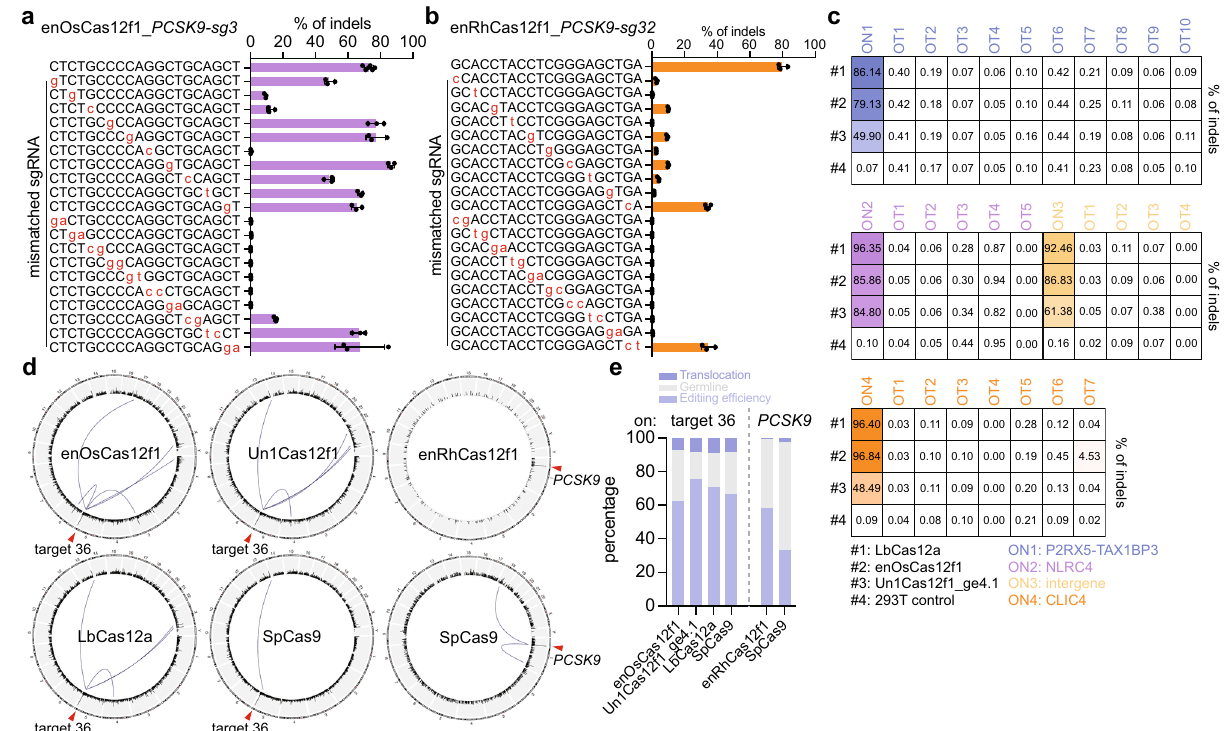
sequencing. d , e PEM-seq genome-widely quanti fi ed the translocation ef fi ciencies induced by off-target indels of enOsCas12f1 and enRhCas12f1. Circos plot showing theoff-targetsitesthatwerelinked tothebaitDSB(redtriangle, d ).Percentagesof translocation, germline, and editing ef fi ciency calculated by PEM-seq analysis of enOsCas12f1, Un1Cas12f1_ge4.1, LbCas12a, SpCas9, and enRhCas12f1 ( e ). Source data are provided as a Source Data fi